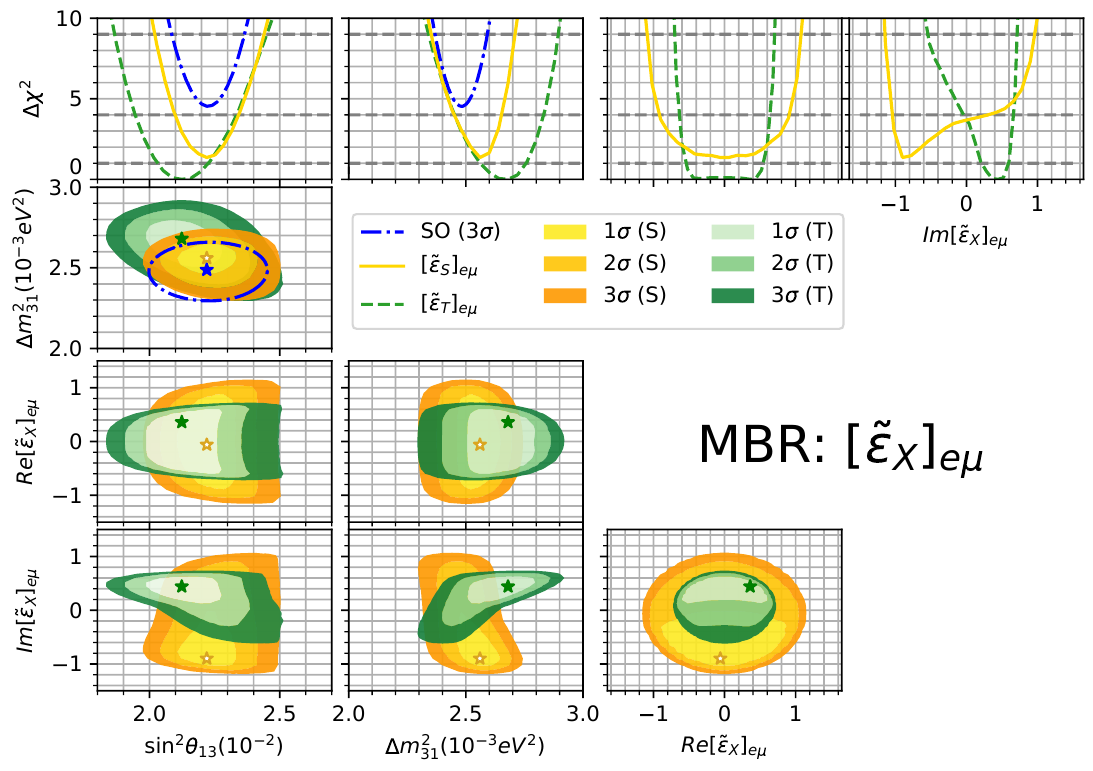
Figure 7 . The same as in figure 3 but for [˜ (cid:15) X ] eµ interactions.